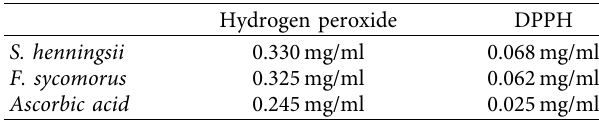
Table 5: % in vitro DPPH radical scavenging activities of DCM extracts of S. henningsii and F. sycomorus . Groups